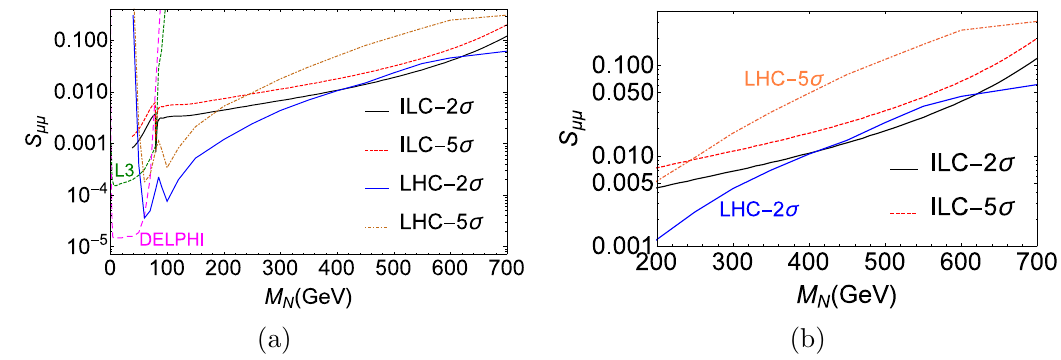
Figure 11 . Sensitivity on S (cid:22)(cid:22) at the ILC. (b) is an enlarged version of (a) in the range of 200{ 700 GeV. For comparison, the 95% bound from the L3 [75] and DELPHI [76] searches and simulated LHC results in [37] are included.